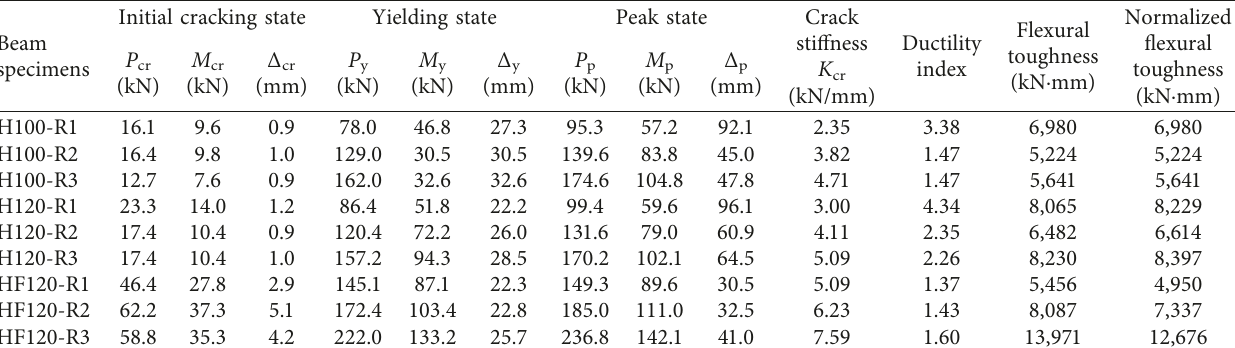
Table 3: Experimental results of the beam